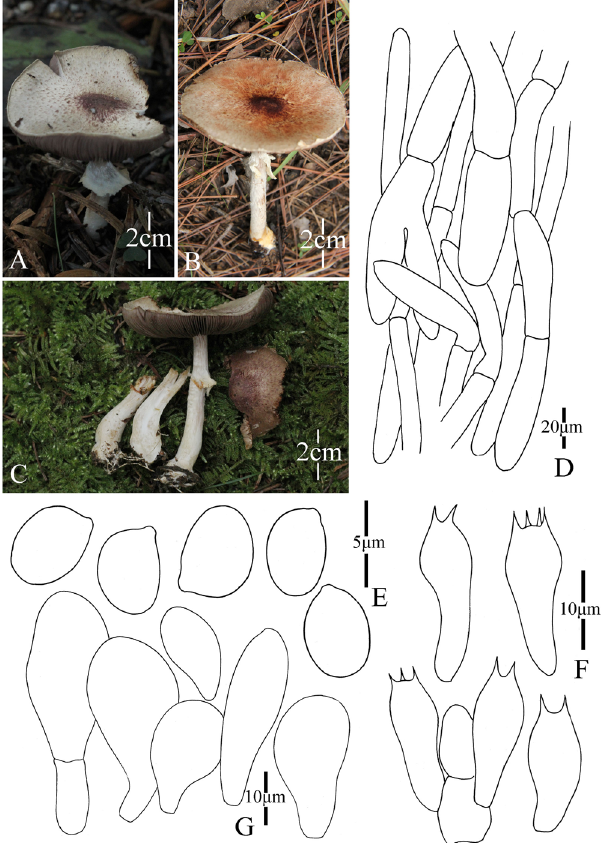
Figure 6. Morphology of Agaricus jingningensis ( ZRL20151562 , holotype), ( A – C ): Basidiome in field ( A , C ). ZRL20151562 ; ( B ). ZRL2014248 ); ( D ). Pileipellis hyphae; ( E ). Basidiospores; ( F ). Basidia, and ( G ).